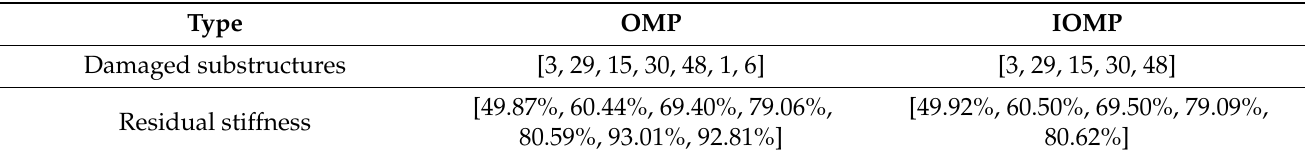
Table 3. Identification results of space truss by OMP and IOMP